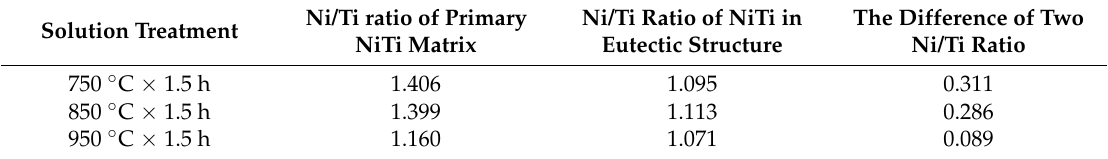
Table 1. The Ni/Ti ratio of Ni41Ti41Nb18 specimens in primary NiTi matrix and the NiTi in eutectic structure. Solution